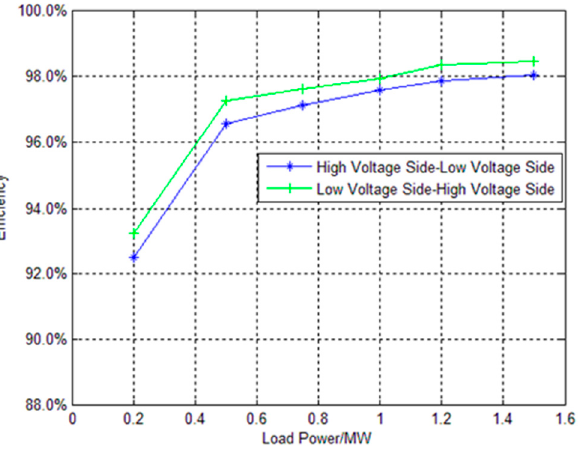
Figure 12. Efficiency curve of the CLLC under different load conditions. Figure 12. E ffi ciency curve of the CLLC under di ff erent load